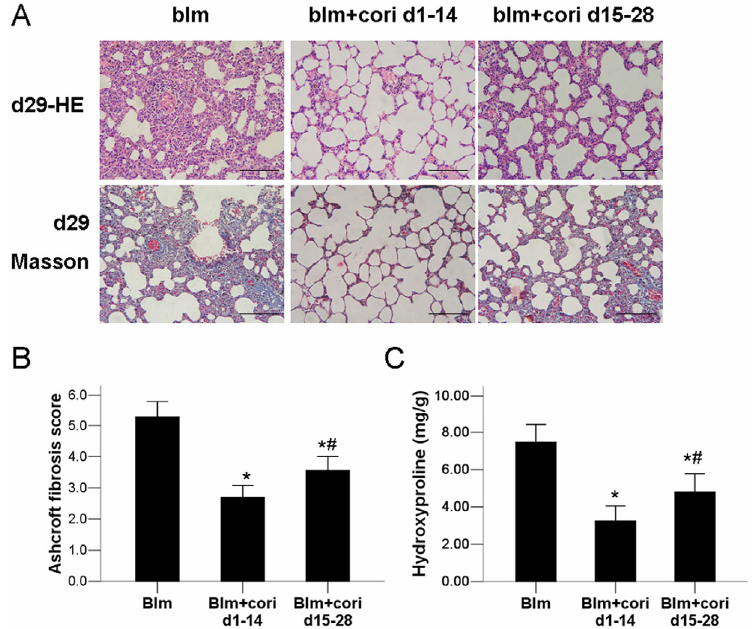
Figure 4. The protective effect of in corilagin on bleomycin-induced lung pathology is time-dependent. ( A ) Representative lung pathology at day 29 in mice without (blm group) or with i.p. injection of corilagin (100 mg/kg) from days 1–14 (blm+cori d1–14 group) or days 15–28 (blm+cori d15–28 group); ( B ) Ashcroft fibrosis score in each group; ( C ) Hydroxyproline content in each group. H&E and Masson’s trichrome, scale bars represent 200 µm. * : p < 0.05 compared with the blm group; #: p < 0.05 compared with the blm+cori d1–14